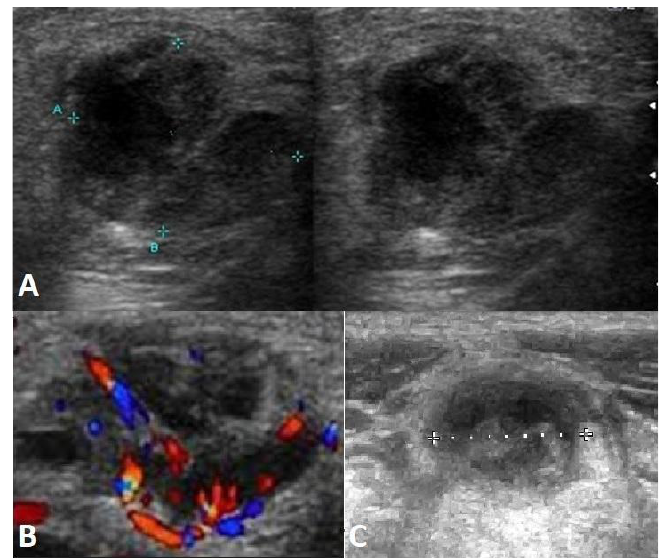
Figure 2. Chest MRI at the moment of LBCL diagnosis with the indication of carotic pathologic lymph nodes masses with arrows. ( A ) T2 STIR sequence axial. ( B ) T2 STIR sequence coronal.